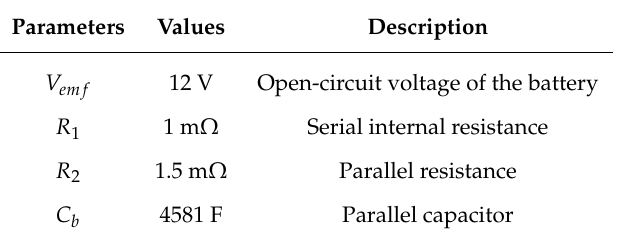
Table 3. Numerical values of the battery